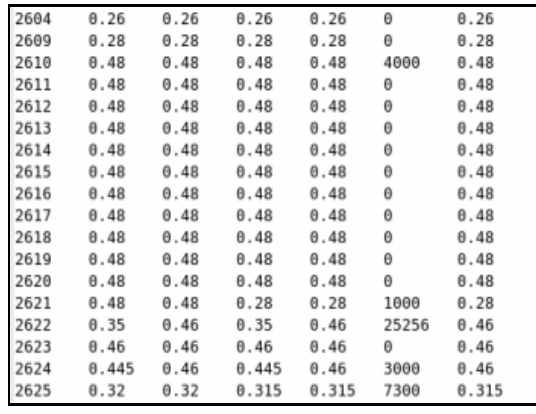
Figure 4. Data in the output table without null